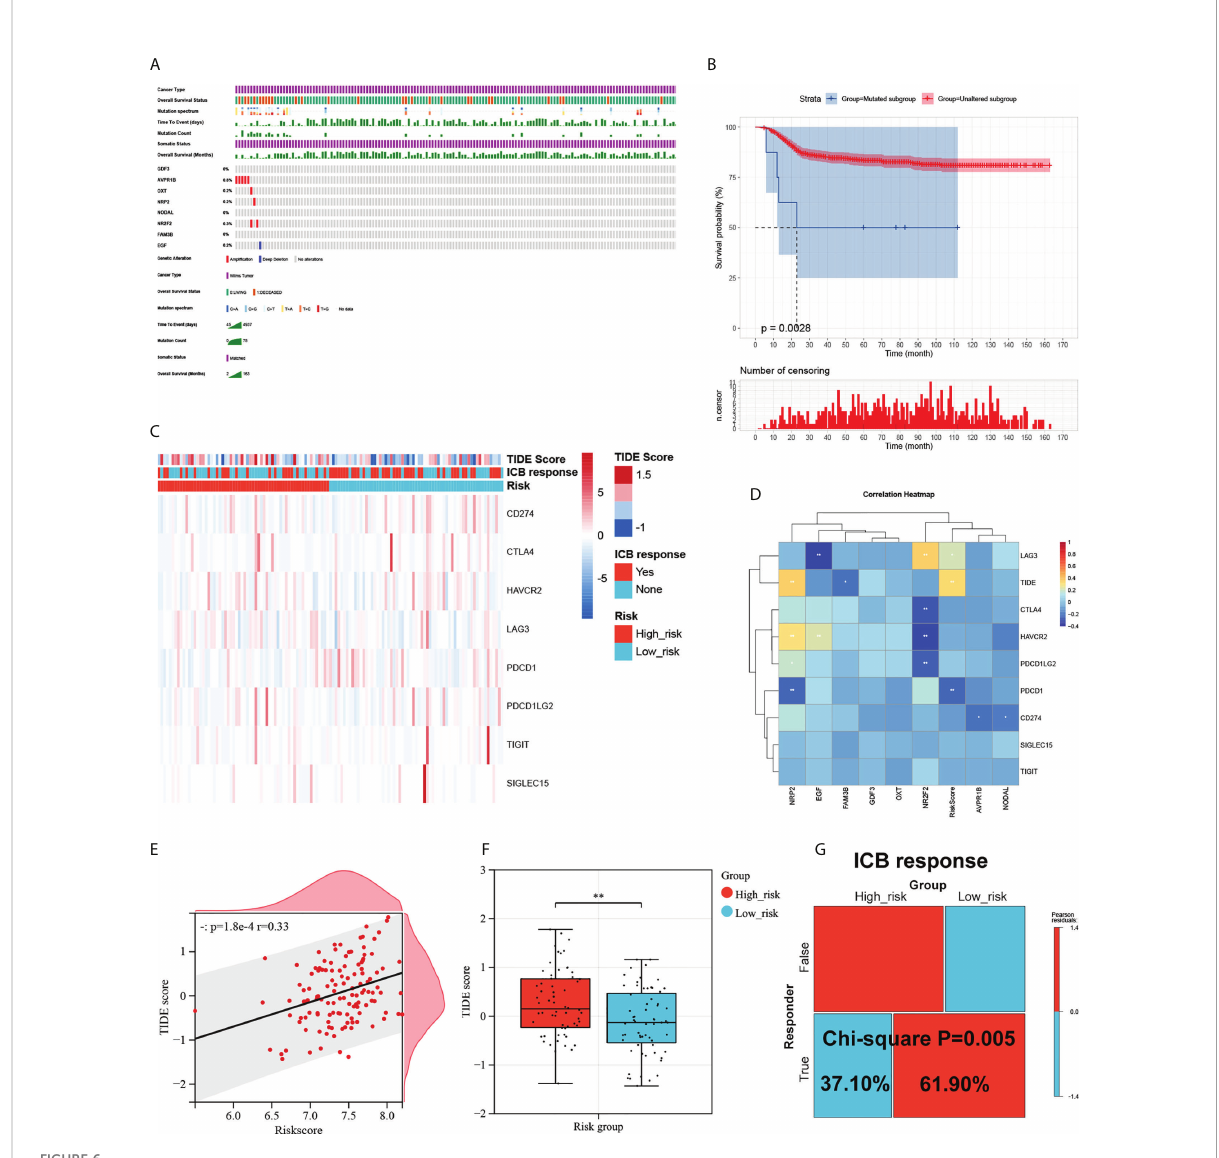
FIGURE 6 Mutational landscape of the signature and its effect on the immune response. (A) Mutational landscape of the immune-genes in TARGET-wt cohort. (B) Survival analysis of the mutated subgroup versus unaltered subgroup in TARGET-wt cohort was provided using Kaplan-Meier curve. (C) Heatmap of immune checkpoint molecules ’ expression, TIDE score, and ICB response based on the signature. (D) The correlation heatmap of eight immune-genes and riskcore with immune checkpoint molecules and TIDE score. (E) Scatter plots depicting correlation of the immune- based risk signature with TIDE score. (F) Box plot showing the differences of TIDE score between the high- and low-risk subgroups in TARGET- wt cohort. (G) Immune response difference between the high- and low-risk subgroups based on TIDE score in TARGET-wt cohort. *, and ** indicate a signi fi cance level of 0.05 and 0.01,